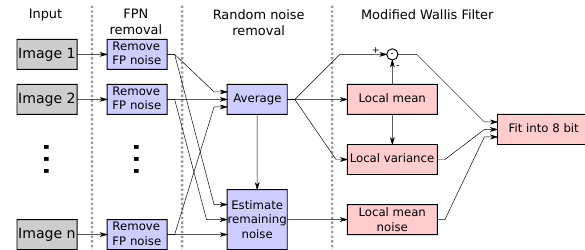
Figure 2. Flowchart of the proposed